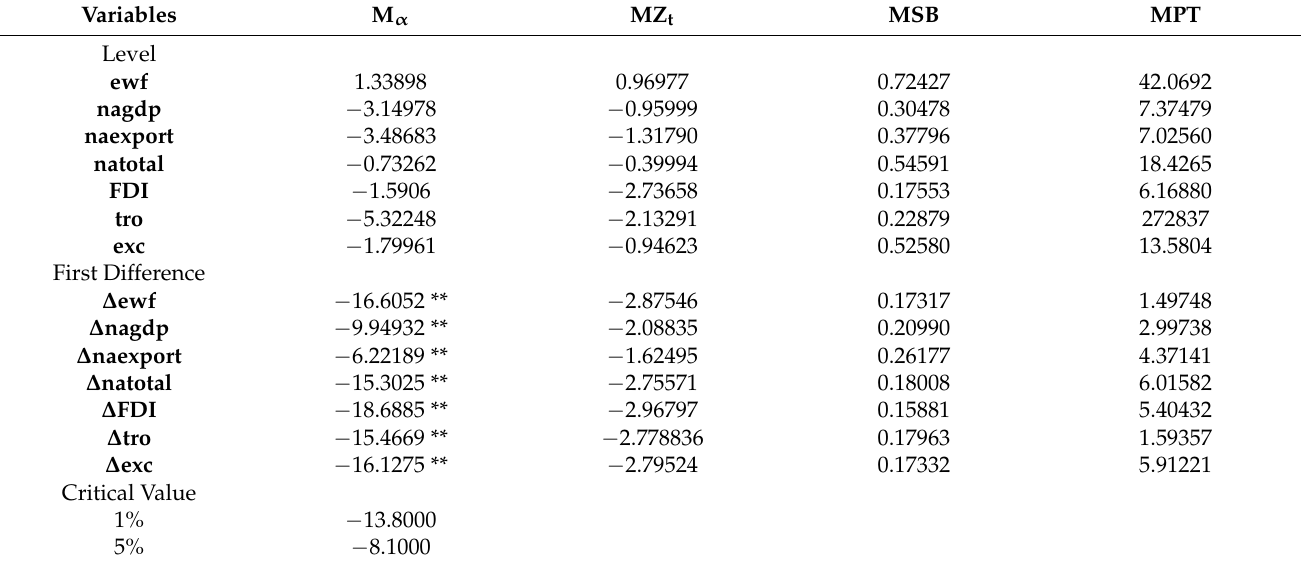
Table 2. NG Perron unit root